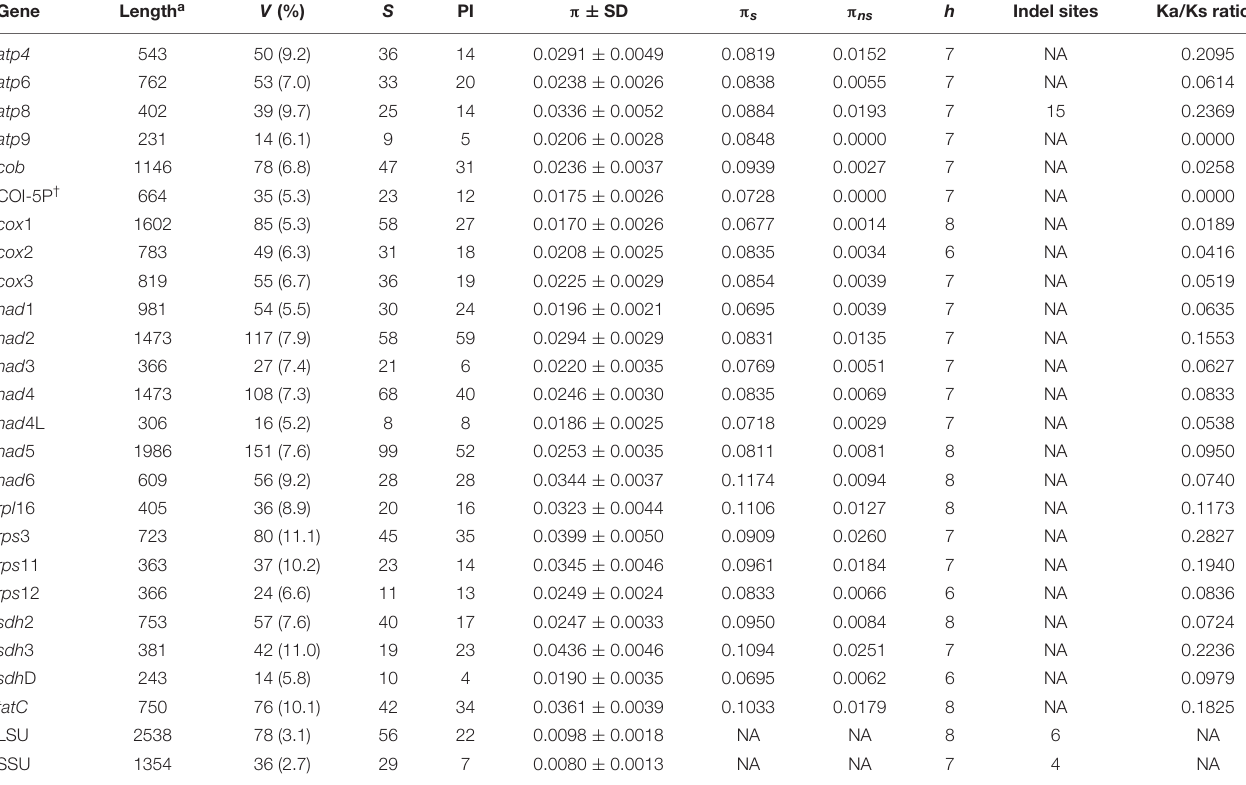
TABLE 2 | A comparison of 23 protein-coding and two ribosomal genes in Gelidiella fanii . Gene Length